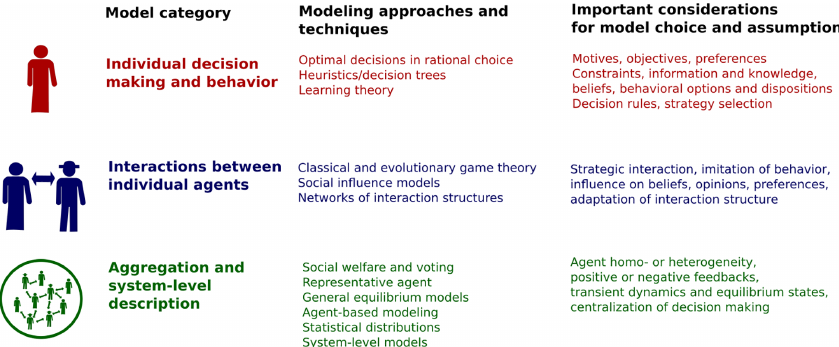
Figure 1. Overview of modeling categories, corresponding modeling approaches, and techniques discussed in this paper and important considerations for model choice and assumptions about human behavior and decision